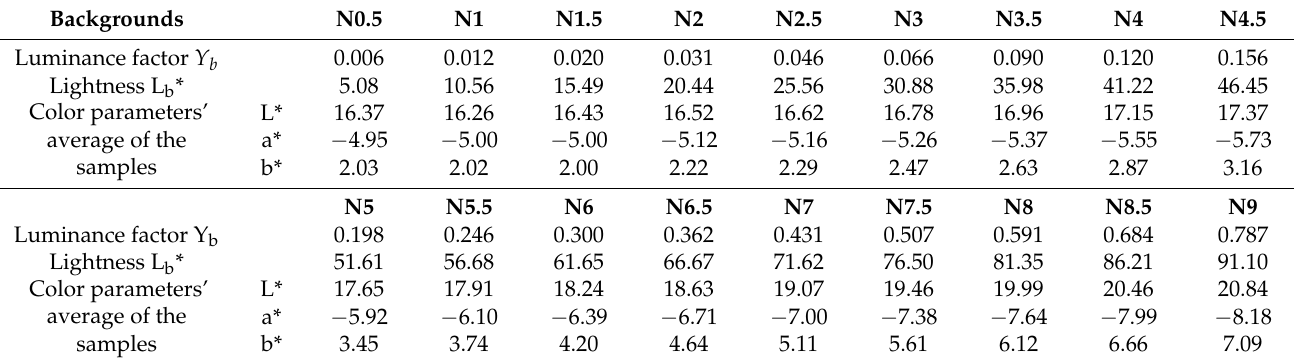
Table 3. Serpentine jade’s color on 18 Munsell neutral